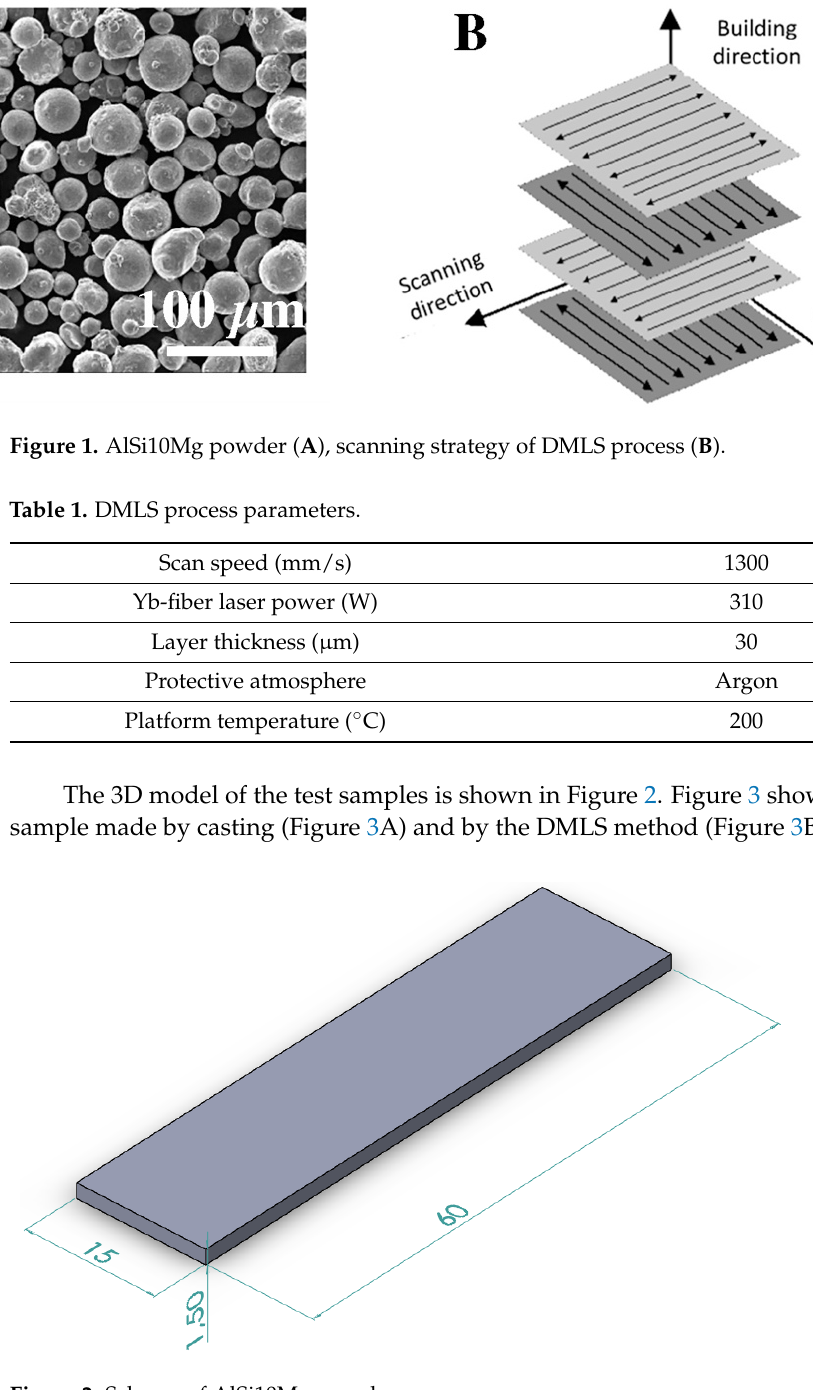
Figure 2. Scheme of AlSi10Mg sample.